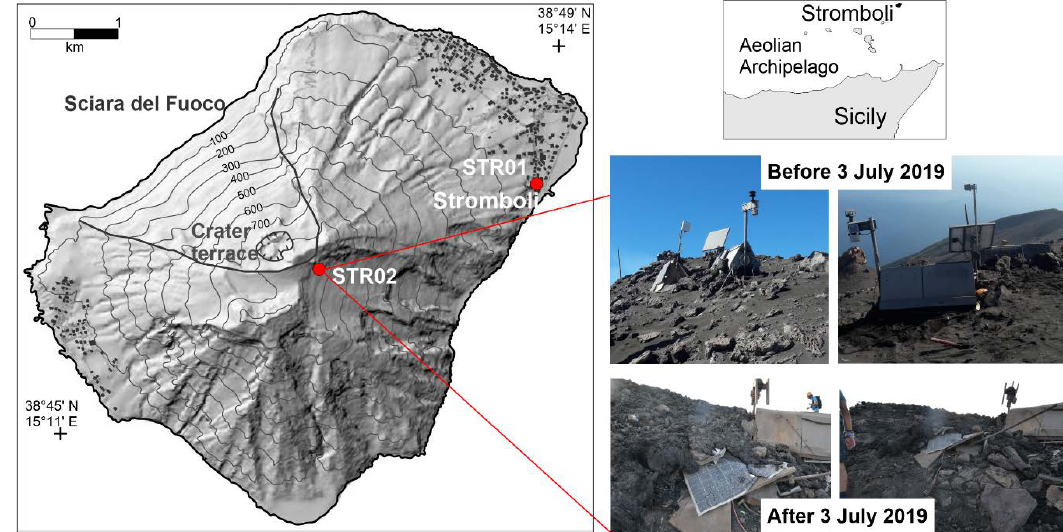
Figure 1. Stromboli map with the location of the STR02 and STR01 stations (CO 2 fluxes measurements) on the summit and peripheral areas of the volcano in the Pizzo sopra La Fossa and Scari, respectively. Pictures of the STR02 equipment before and after the 3 July 2019 paroxismal events have been inserted.